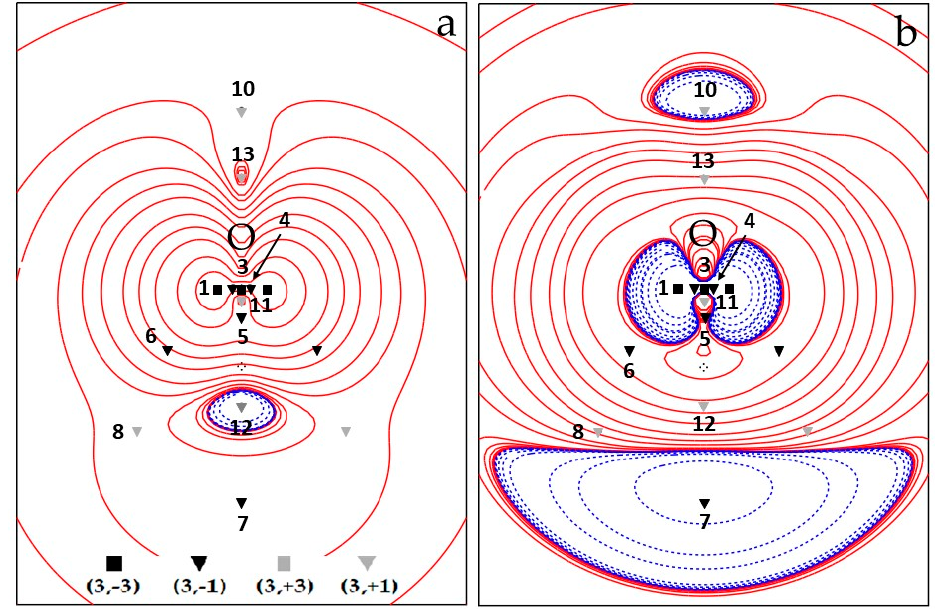
Figure 2. CAS contour plots in the σ v’ plane of 3 B 1 H 2 O containing the O nucleus: ( a ) electron spin density s and ( b ) electron spin density Laplacian ∇ 2 s. For all other details, see the caption of Figure 1. Similar plots for the other wavefunction models are shown in Figures S2, S3 (UHF) and S4, S5 (ROHF). In addition, Figures S6–S8 display the differences between CAS and UHF spin densities s (Figure S6), or between CAS and UHF ρ α (Figure S7) or ρ β (Figure S8) electron densities.